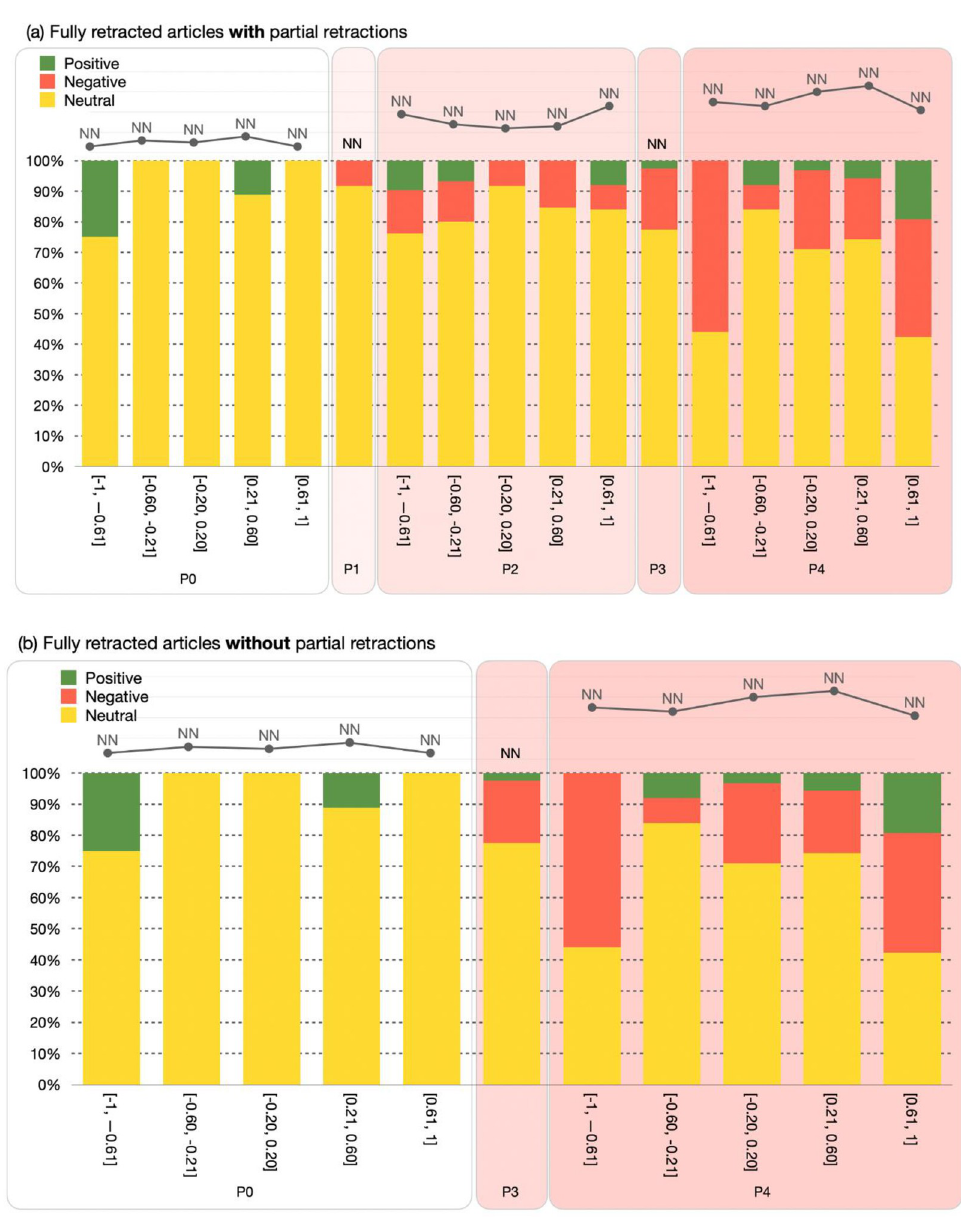
Fig 5. A graphical representation for the distribution of the in-text citations in the PERIOD-SET. The periods P0, P2, and P4 are split in fifths, while P1 and P3 are represented using in one slice. The graphic has two different based on the categories of the retracted articles, i.e. RET-A (in the top) and RET-B (in the bottom). The graphic also highlights the neutral, negative and positive in-text citations.